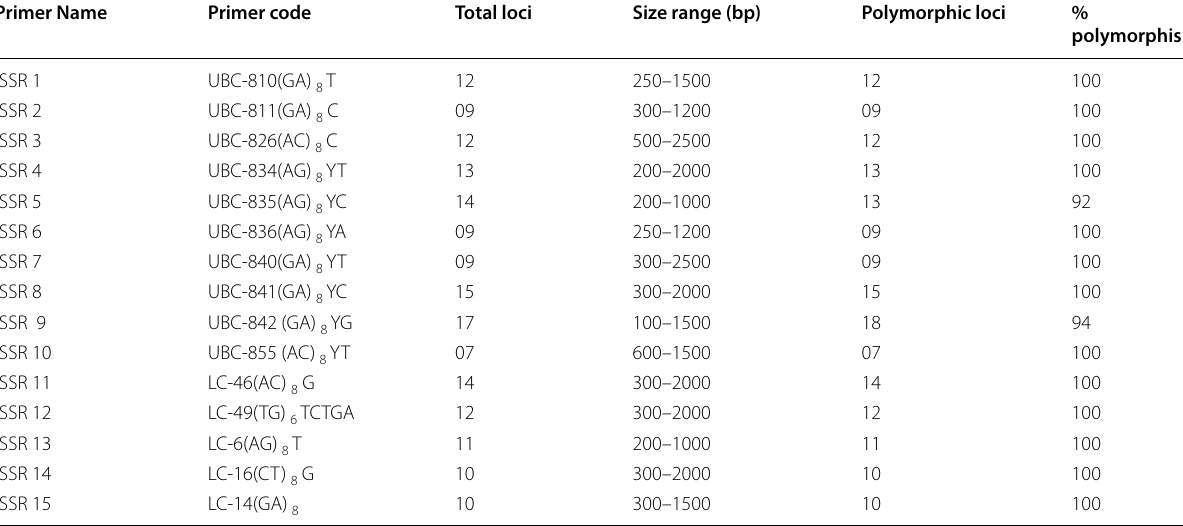
Table 2 Pairwise score of PCR amplification product of ISSR markers Primer